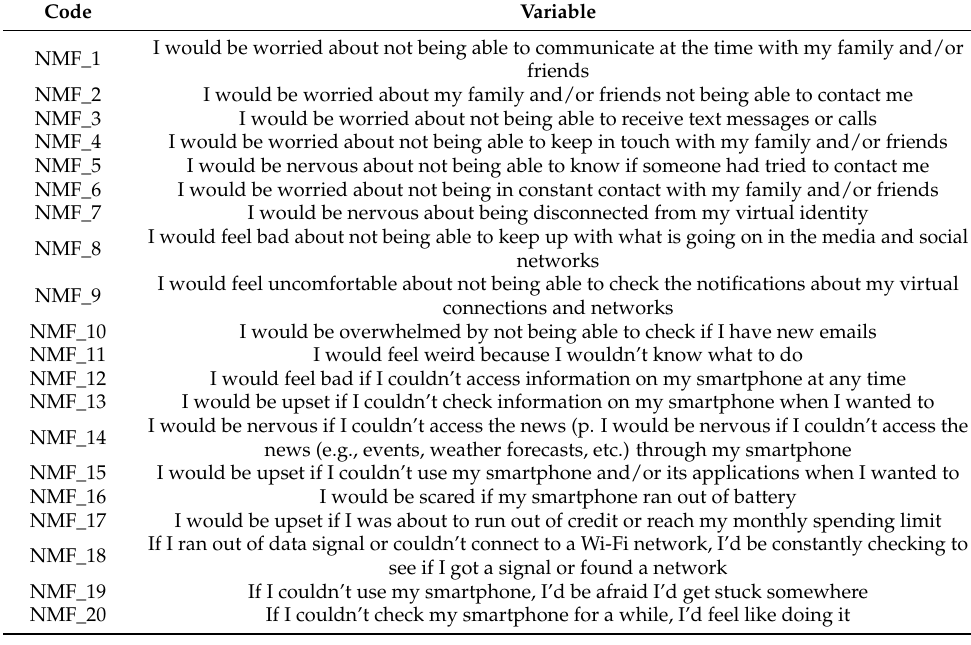
Table A1. Coding of the variables of the NMP-Q